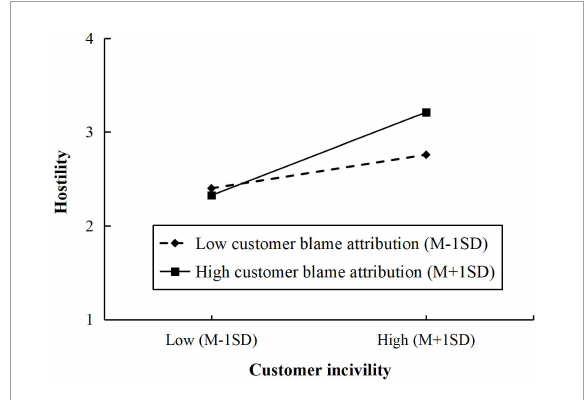
FIGURE2 The moderating effect of customer blame attribution on the relationship between customer incivility and hostility.